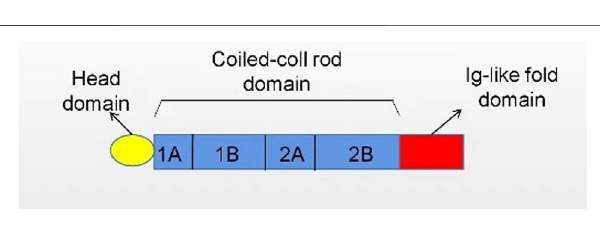
FIGURE 2 | The structure of lamin. Nuclear lamins contain three domains:ahead domain, acoiled-coilroddomain, and anIg-likefold domain.